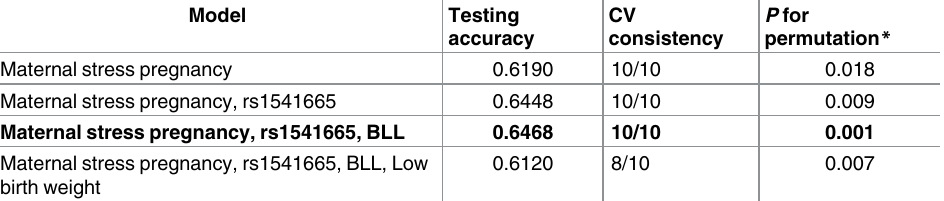
Table 5. MDR analyses of the gene-environment interactions between SNP rs1541665and ADHD risk factors in ADHD risk in combined samples.